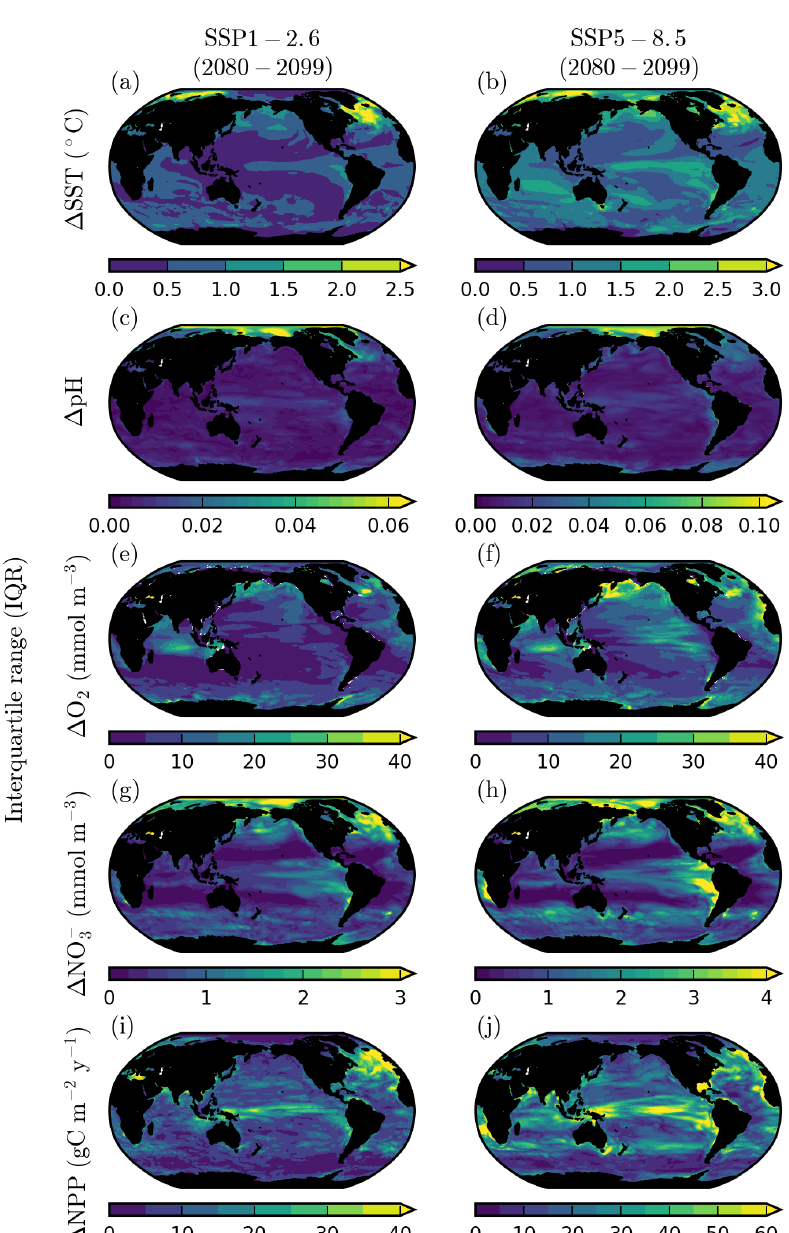
Figure A1. The interquartile range associated with CMIP6 projections of upper-ocean impact drivers. The CMIP6 interquartile range ( Q 3 – Q 1 ) of projected anomalies in (a, b) sea surface temperature ( ◦ C), (c, d) surface ocean pH, (e, f) subsurface dissolved O 2 concentration (averaged between 100 and 600m ; mmolm − 3 ), (g, h) euphotic-zone NO − (averaged between 0 and 100m ; mmolm − 3 ), and (i, j) depth- 3 integrated net primary production (gCm − 2 y − 1 ). The corresponding mean projections are given in Fig.